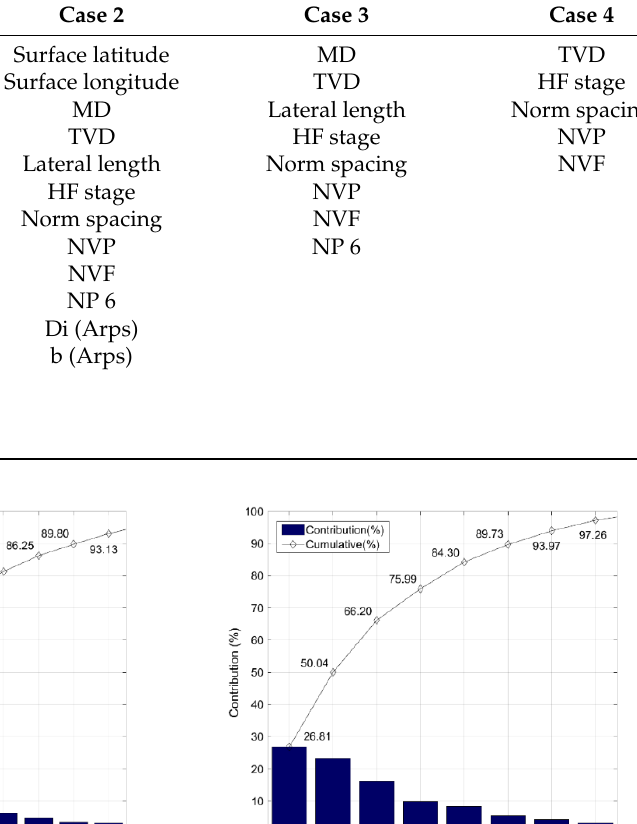
Table 4. List of input attributes in the case studies.